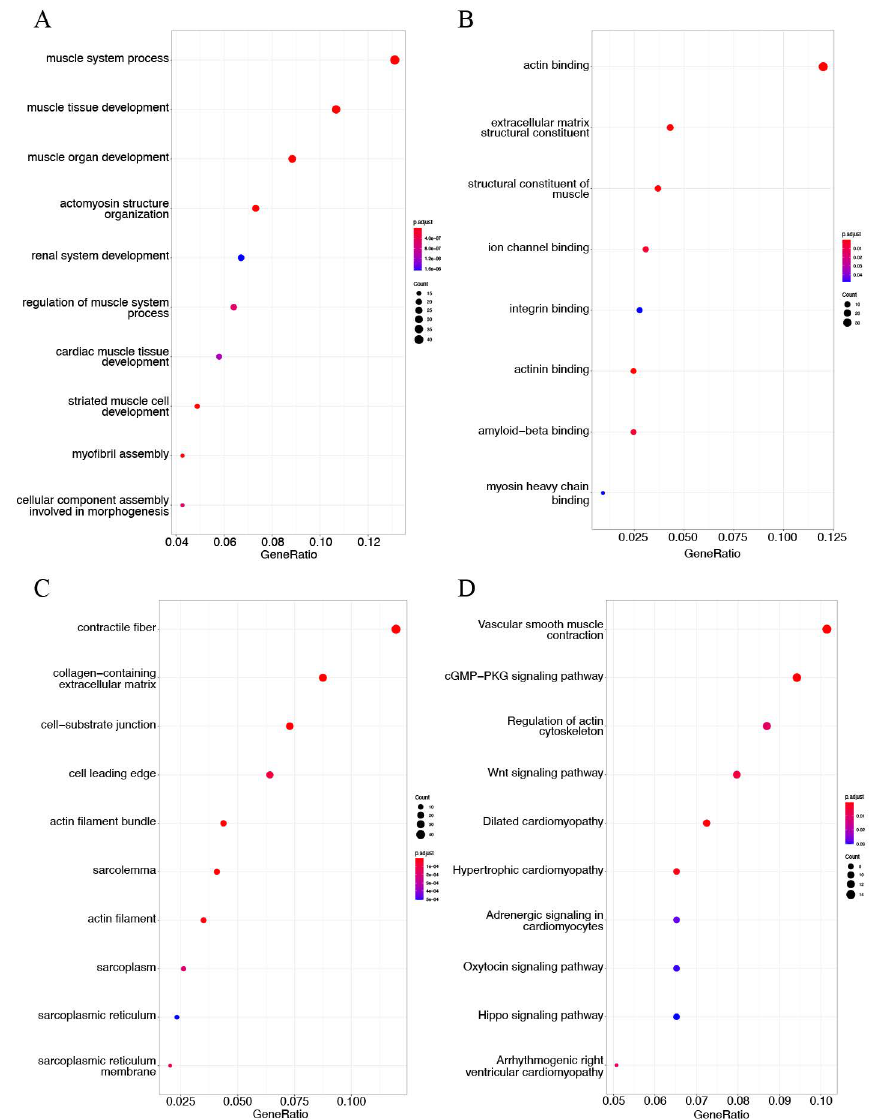
Figure 6. GO term enrichment and KEGG pathway analysis of downregulated DEGs in AS in GSE100927. GO term annotation analysis includes three sections: ( A ) biological process (BP), ( B ) molecular function (MF), ( C ) and cellular component (CC). ( D ) The KEGG pathway analysis of downregulated